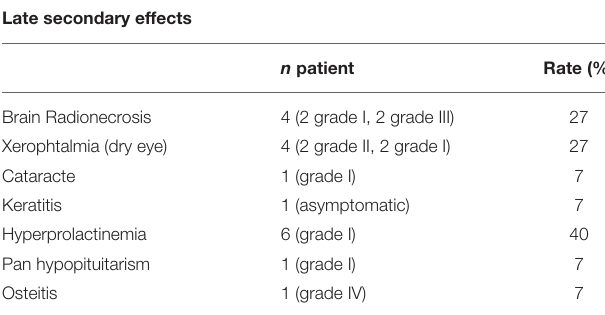
TABLE 4 | Late secondary effects relative to